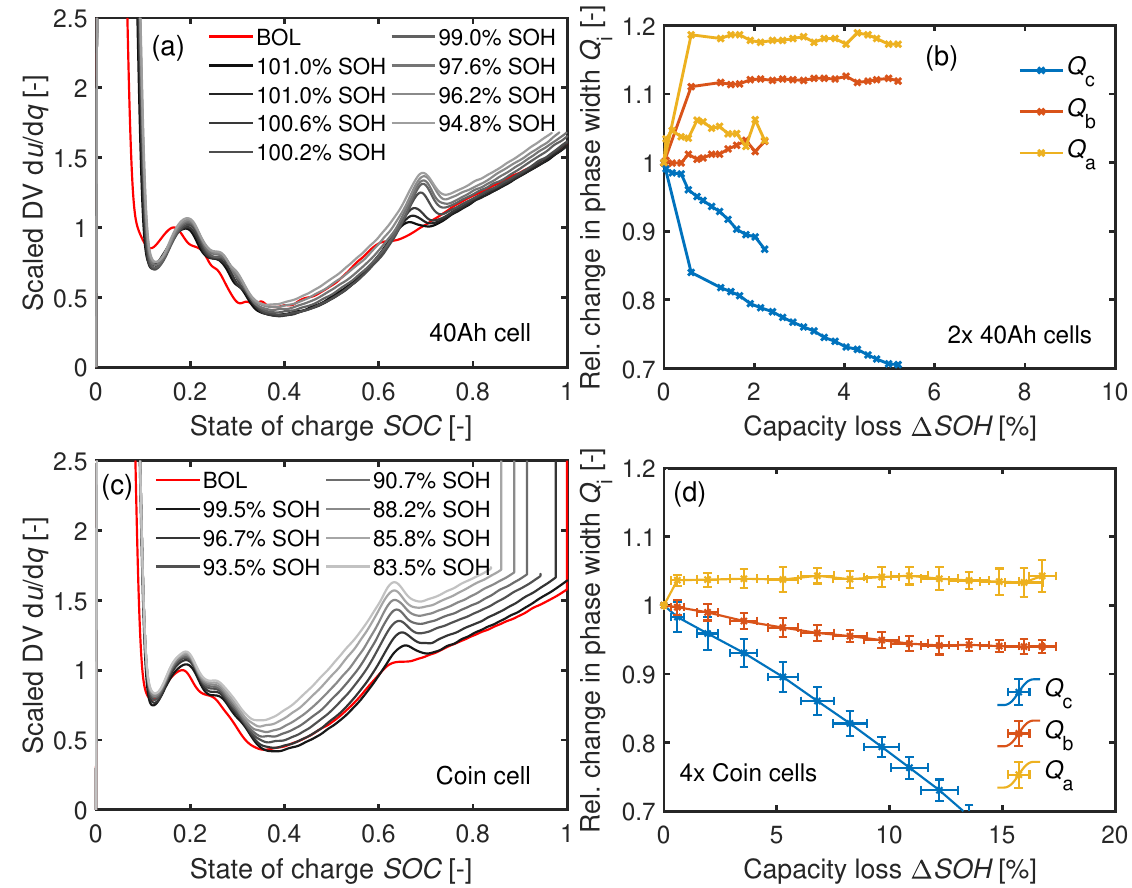
Figure 12. ( a ) DV of a cyclically aged 40Ah cell at T = 25 ◦ C and ( b ) the 40Ah cells’ relative phase width development. ( c ) DV of a cyclically aged coin cell at T = 25 ◦ C with ( d ) the corresponding trend of the phase widths of four aged coin cells.